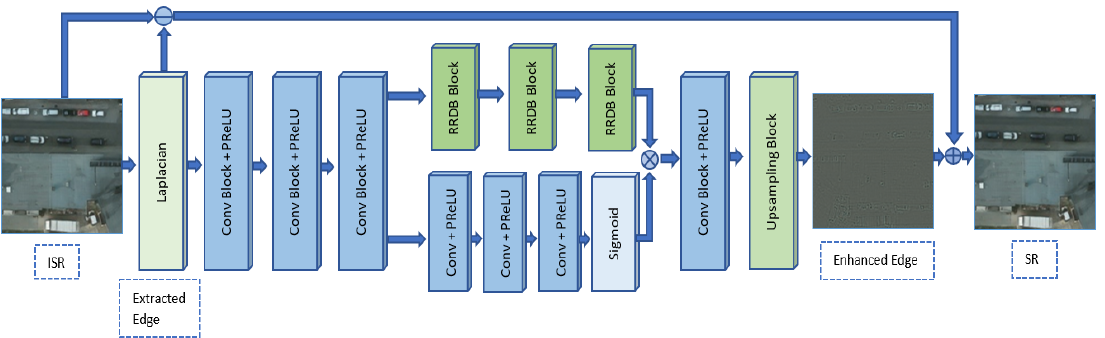
Figure 5. Edge-enhancement network where input is an ISR (intermediate super-resolution) image and output is a SR (super-resolution)